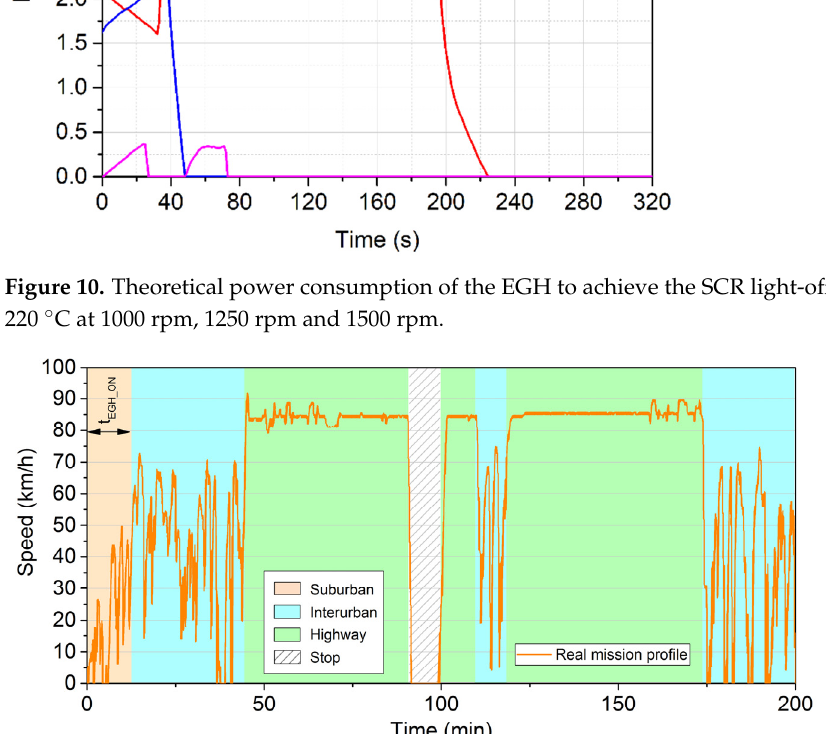
Figure 10. Theoretical power consumption of the EGH to achieve the SCR light-off temperature of 220 °C at 1000 rpm, 1250 rpm and 1500 rpm.